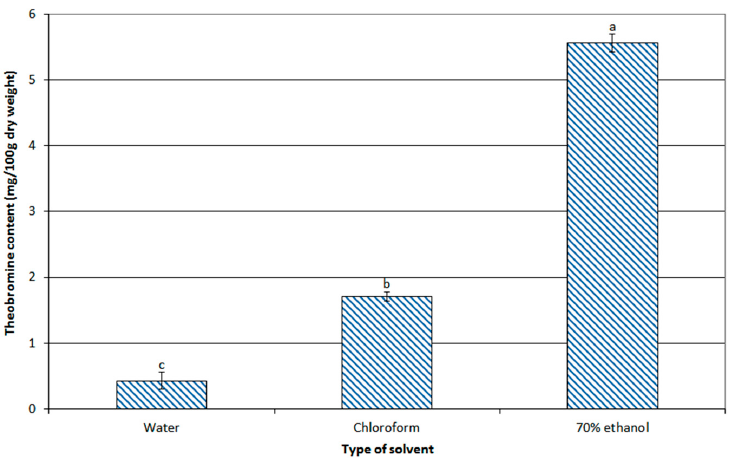
Figure 5. Effect of solvents on theobromine content from cacao pod husk. Different letters (a, b, c) indicated significant differences between treatments ( p < 0.05).